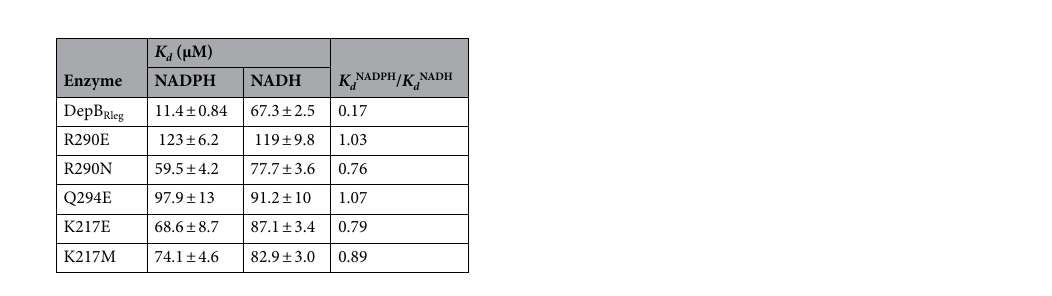
(Table 3). Substitutions for neutral residues as in the case for R290N displayed a moderate change in the K d by fivefold, while for K217M, the K d change relative to the wild type was more pronounced with a nearly sevenfold change. Overall, for all the mutants, there was no appreciable change in K d for NADH. Substrate-binding site. The catalytic mechanism of AKRs involves a stereospecific 4- pro -R hydride trans-